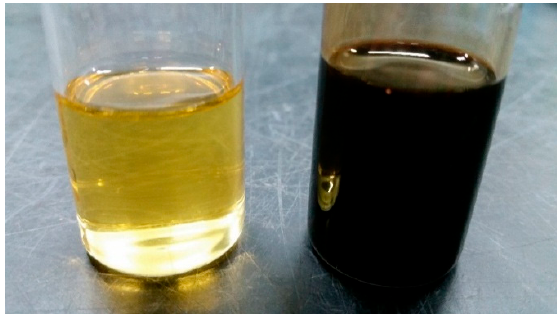
Figure 1. Fresh and waste engine oil.